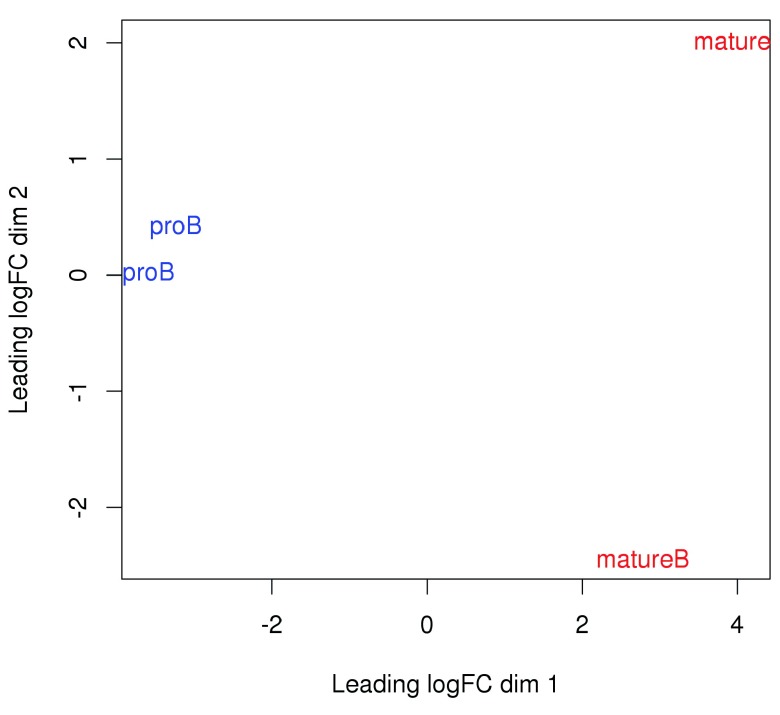
MDS plot with two dimensions for all libraries in the H3K9ac data set.Libraries are labelled and coloured according to the cell type.